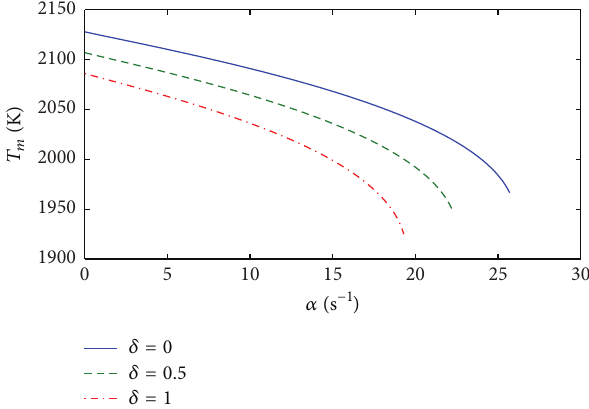
Figure 3: Influence of heat loss parameter on spray flame tempera- ture for different initial droplet loads—evaporation front